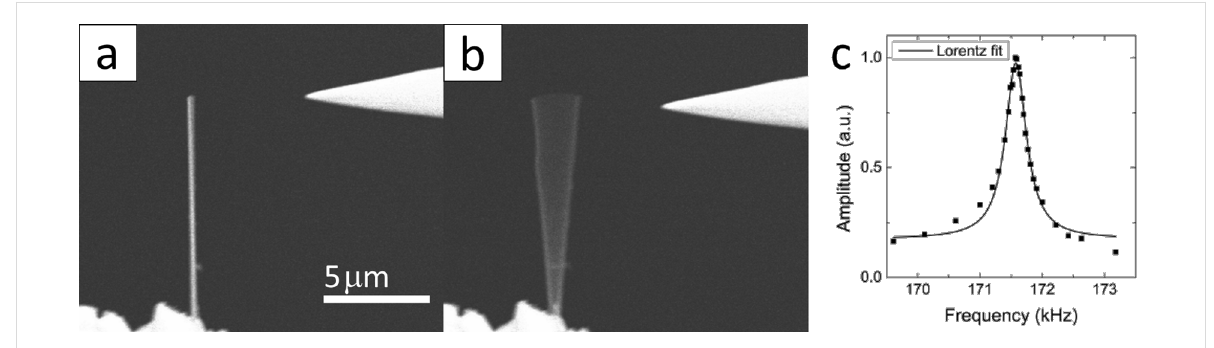
Figure 1: In situ resonance excitation of Sb 2 S 3 NW. SEM images of NW with dimensions: length L = 10 μ m and radius r = 67 nm recorded when the applied electric field frequency is a) far from the natural resonance frequency of the NW and b) at the resonance frequency. c) Amplitude-frequency curve for Sb 2 S 3 NW with ω 0 /2 π = 171.57 kHz and Q = 418.